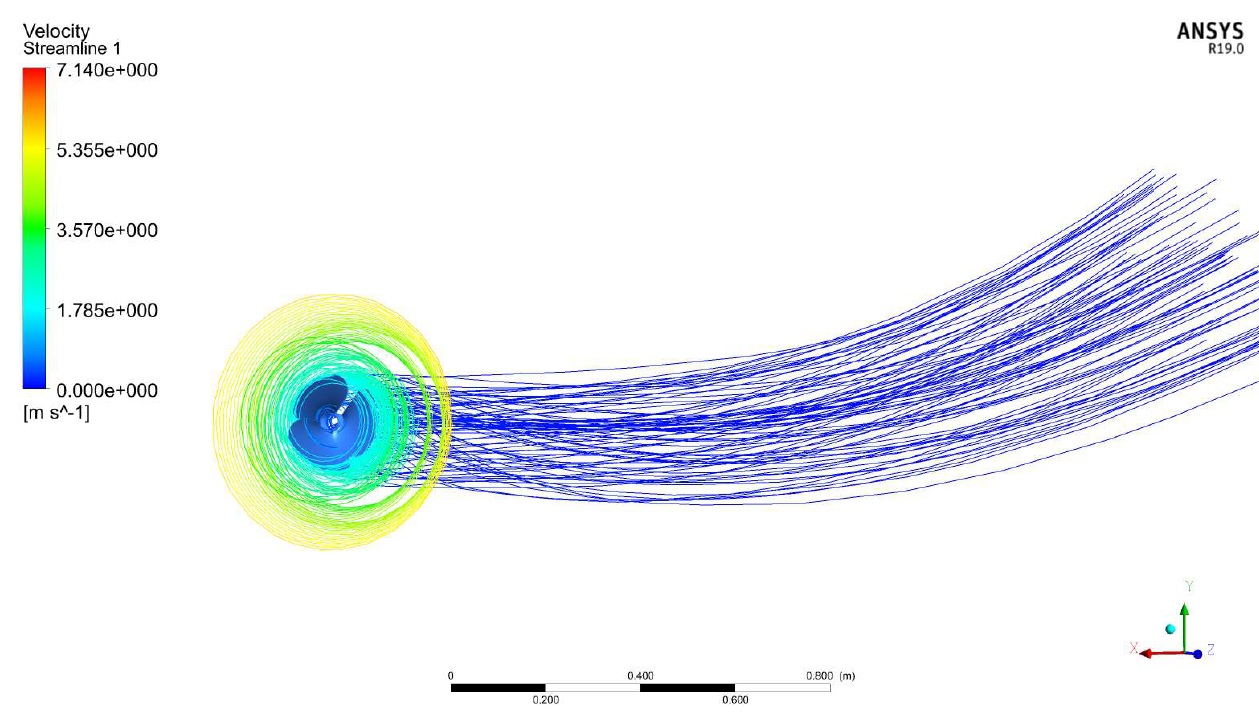
Figure 16. Velocity variations of 200 RPM.